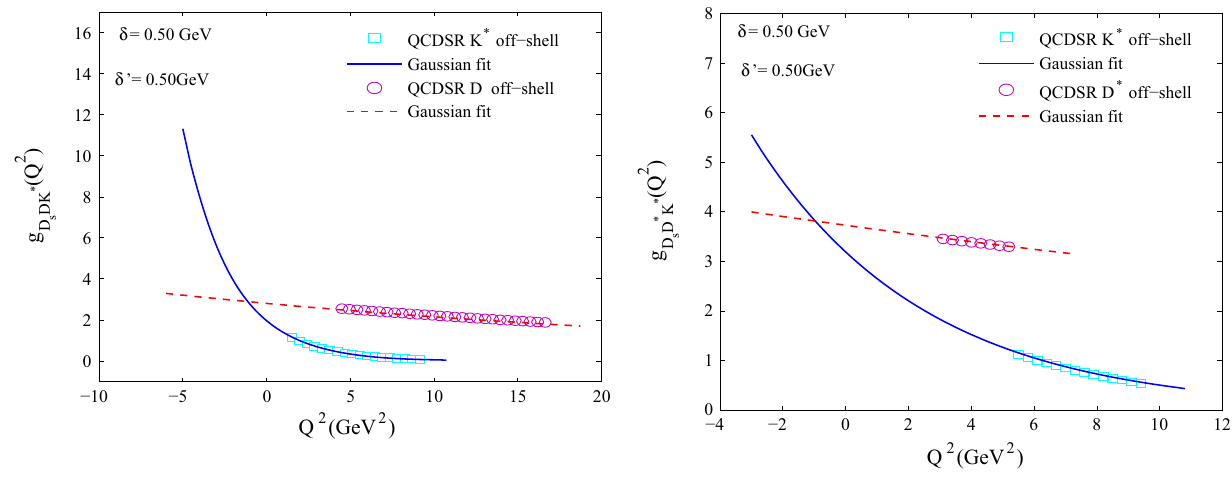
Fig. 7 The strong form factors g D